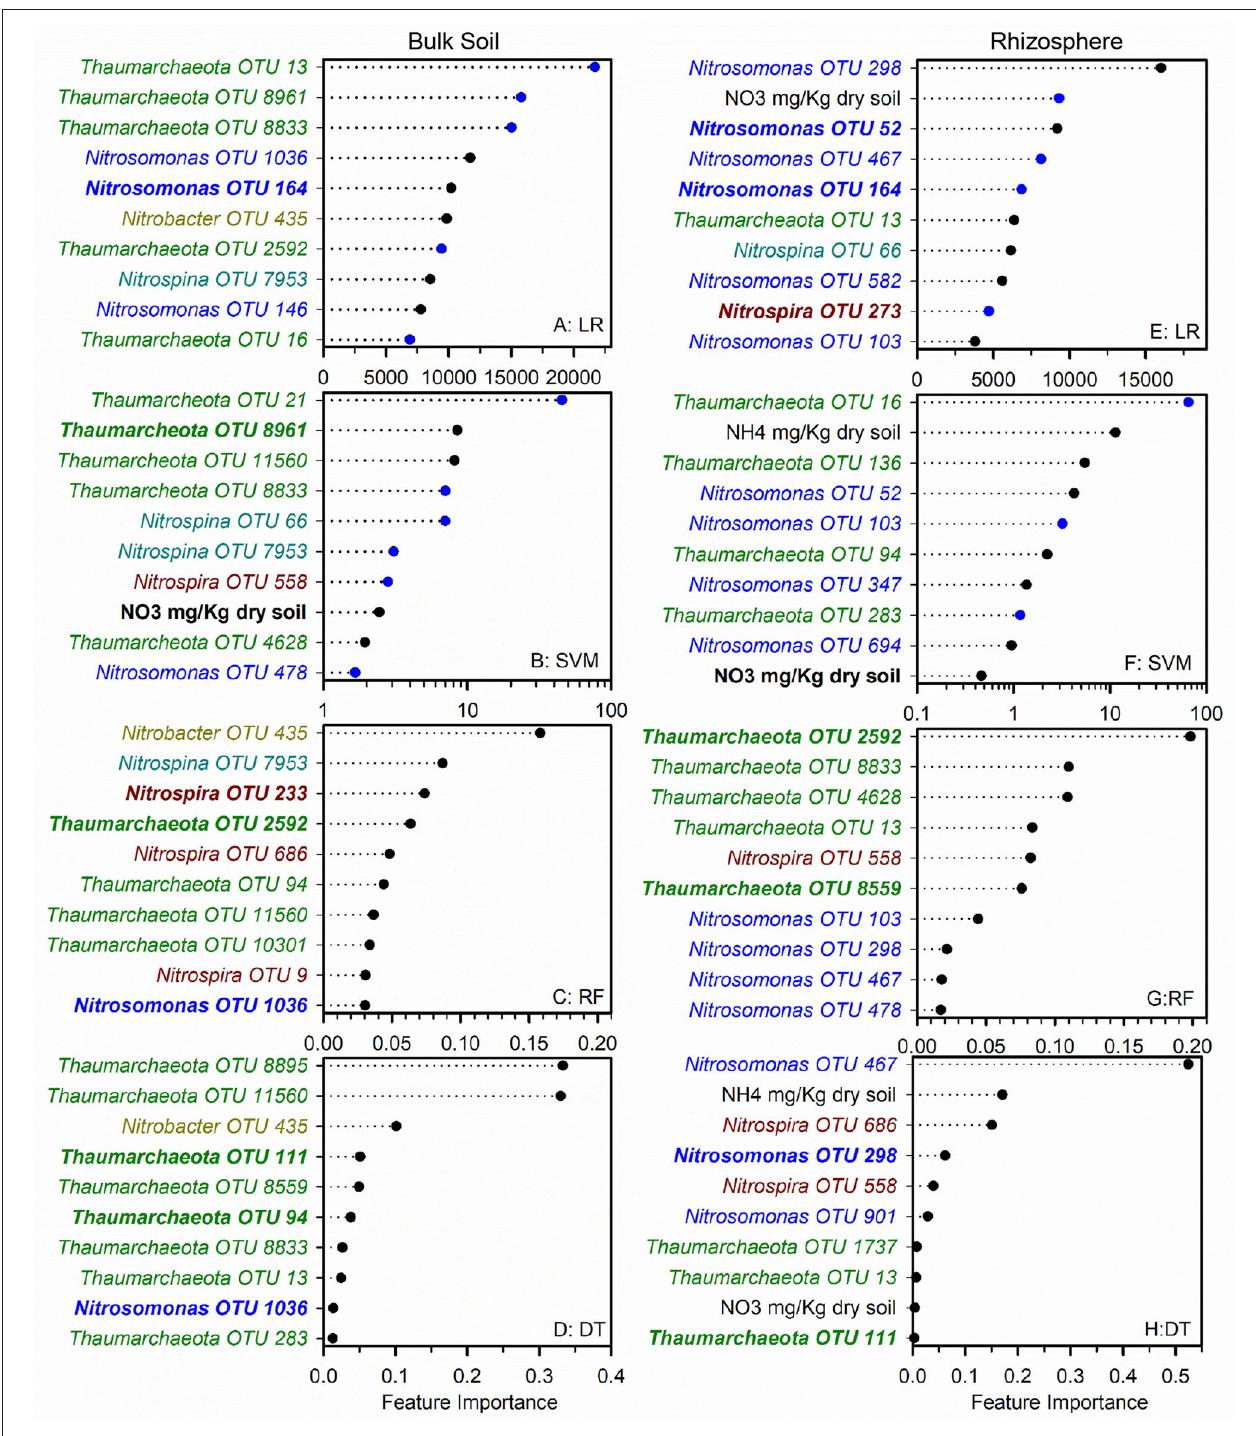
FIGURE 4 | Ranks of absolute feature weights of linear (A,B,E,F) and nonlinear (C,D,G,H) models for bulk soil and rhizosphere. The 10 highest ranked features of absolute feature weights are displayed from highest to lowest. In regression (A,E) and SVM (B,F) , feature importance of OTUs positively associated with nitrification are represented by black dots, and those negatively associated with nitrification are shown in blue. The values for linear regression are the absolute feature importance, while for SVM, the log 10 relative absolute feature importance. Within each model, bold OTUs indicate the same OTUs in bulk soil and rhizosphere. Random Forest (C,G) . Decision Tree (D,H)